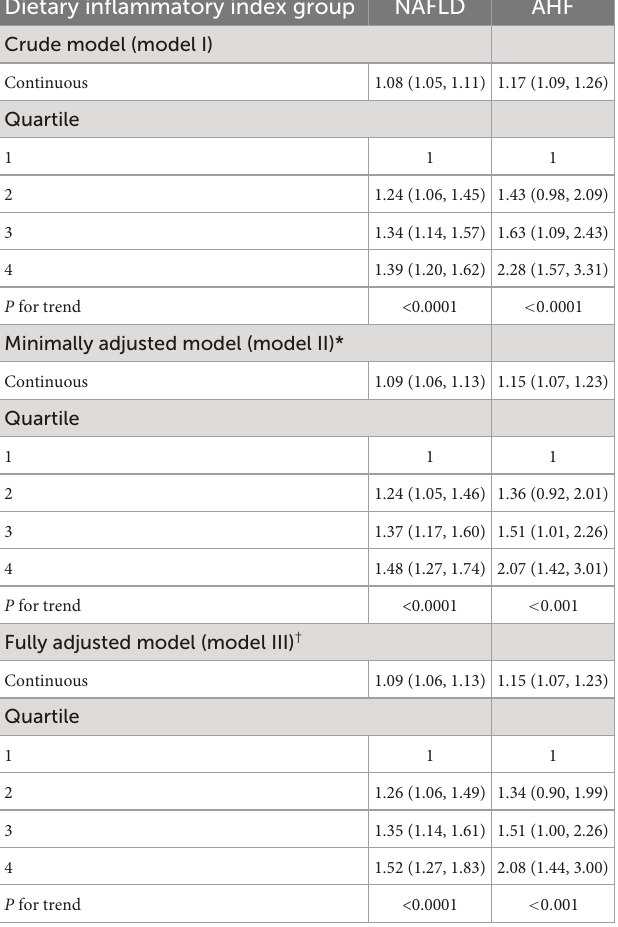
TABLE 2 Association between dietary inflammatory index (DII) and the presence of non-alcoholic fatty liver disease (NAFLD) and advanced hepatic fibrosis (AHF) in the 2005–2016 continuous National Health and Nutrition Examination Survey (NHANES). Dietary inflammatory index group NAFLD AHF Crude model (model